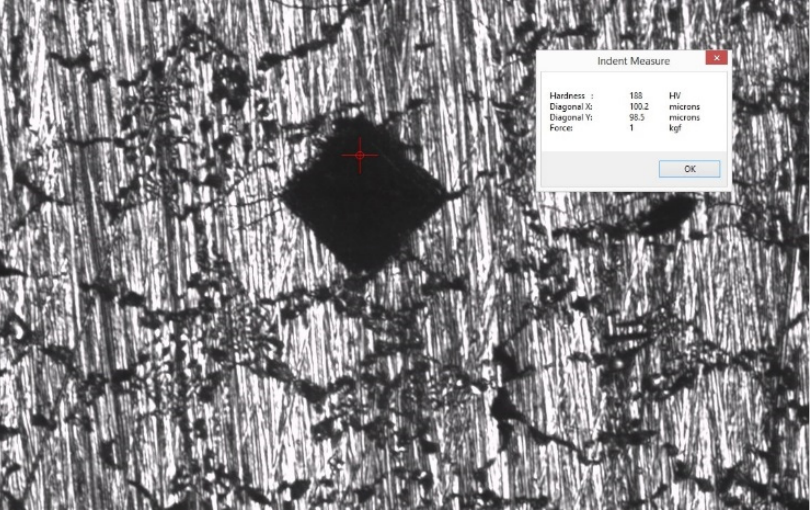
Figure 11. Pyramid indentation during Vickers micro-hardness test.